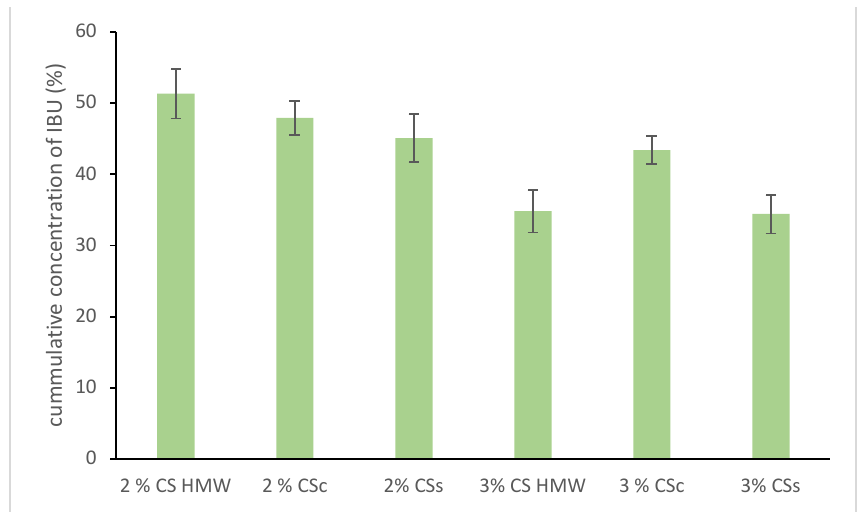
Figure A5. Comparison of the cumulative amount of ibuprofen (%) released from CS hydrogels after 330 min.